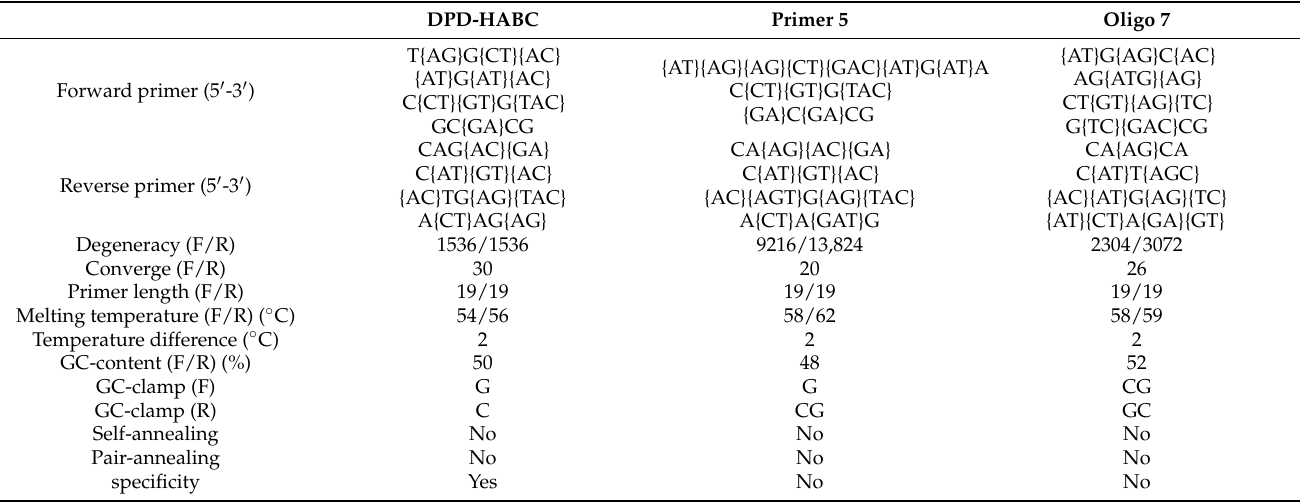
Table 3. Comparison of three methods on a 600 bps DNA